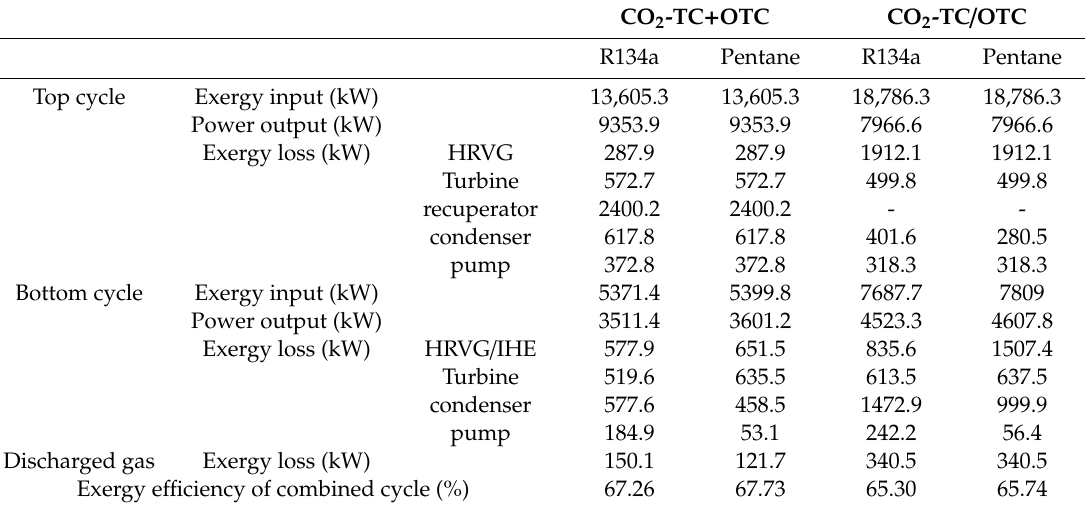
Table 6. The exergy inputs, outputs and losses for the combined